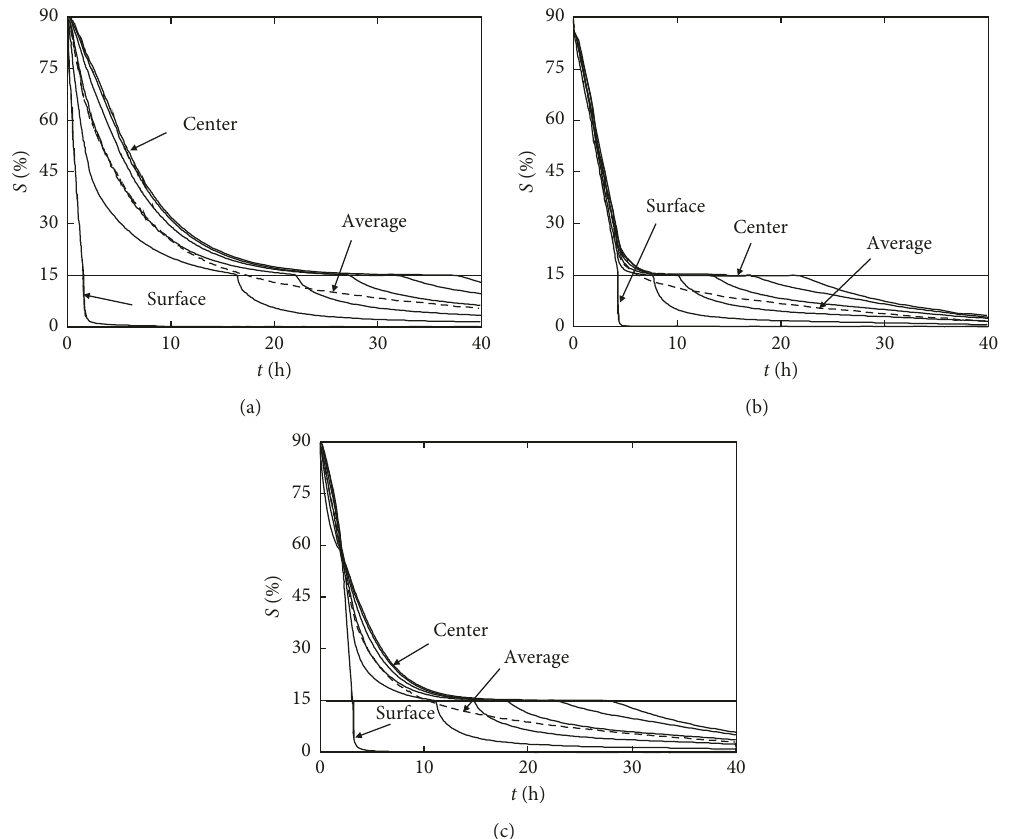
Figure 13: Saturation profiles from left to right: (a) case 1 (100 ± 5 nm); (b) case 2 (1000 ± 100nm); (c) case 3 (100 ± 10; 200 ± 20nm).